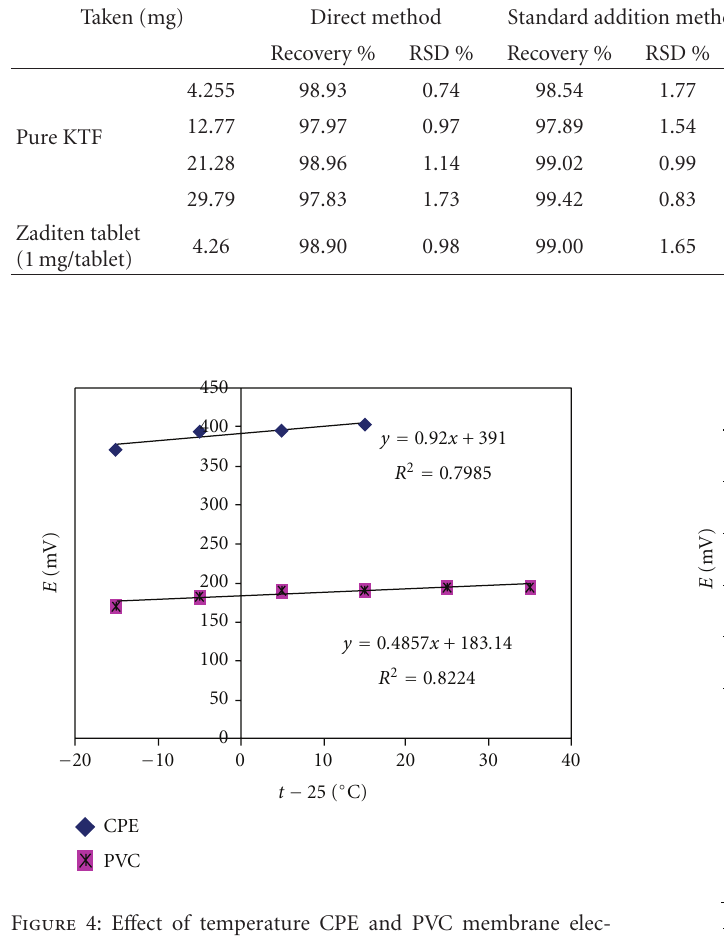
Figure 4: E ff ect of temperature CPE and PVC membrane elec- trodes.